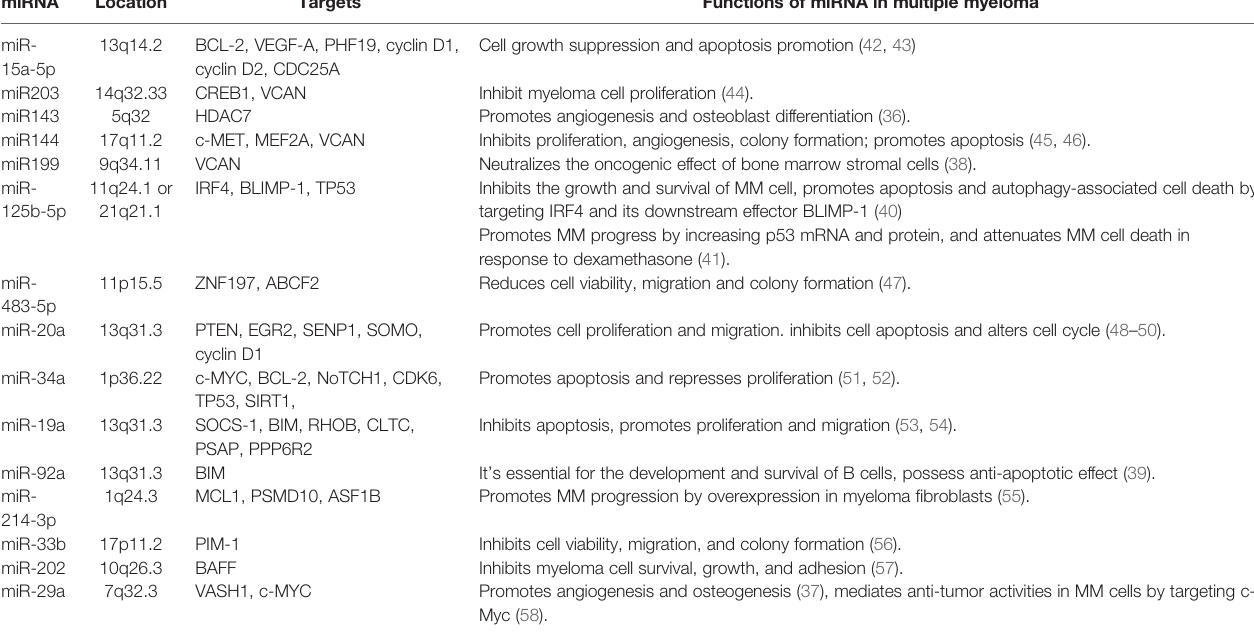
TABLE 6 | Summary of studies on the targets and functions of miRNAs included. miRNA Location Targets Functions of miRNA in multiple